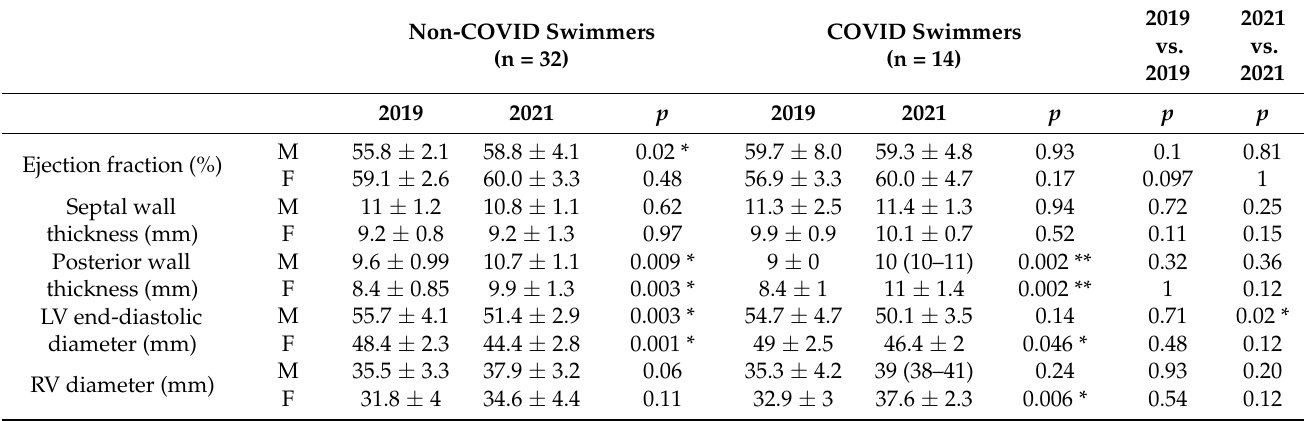
Table 2. Echocardiography results.